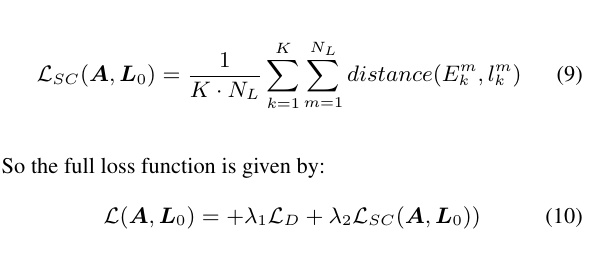
Table 1. Results of evaluation on C2F